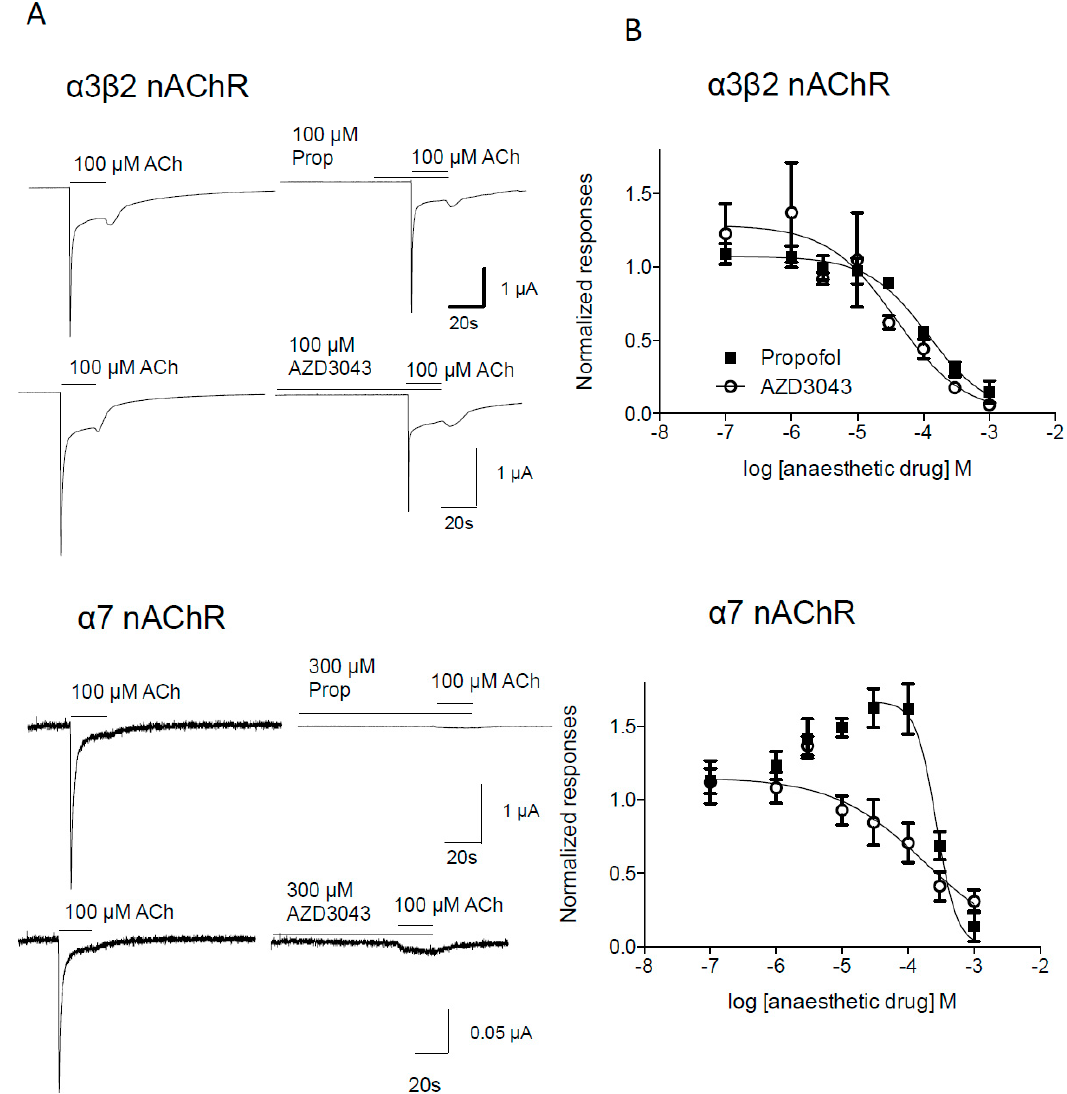
Figure 2. Propofol and AZD3043 concentration-dependently inhibit 100 μ M acetylcholine-induced current responses in Xenopus oocytes expressing the human neuronal α 3 β 2 and α 7 nAChR. Representative traces from one oocyte inhibited by propofol (Prop) or AZD3043 ( A ). Please note that the concentration-response curve for the human neuronal α 7 nAChR subtype is based on area under the curve calculation and not peak (see Section 4.6.). Concentration-dependent inhibition of currents induced by 1 μ M acetylcholine by propofol and AZD3043 at the human neuronal α 3 β 2 and α 7 nAChR subtypes ( B ). Current responses in each oocyte were normalized to the 100 μ M acetylcholine control responses in each oocyte as described in Experimental Section . Each symbol represents mean ± S.E.M. When no error bars are seen, they are smaller than the symbols. Ach = acetylcholine, Prop = propofol.